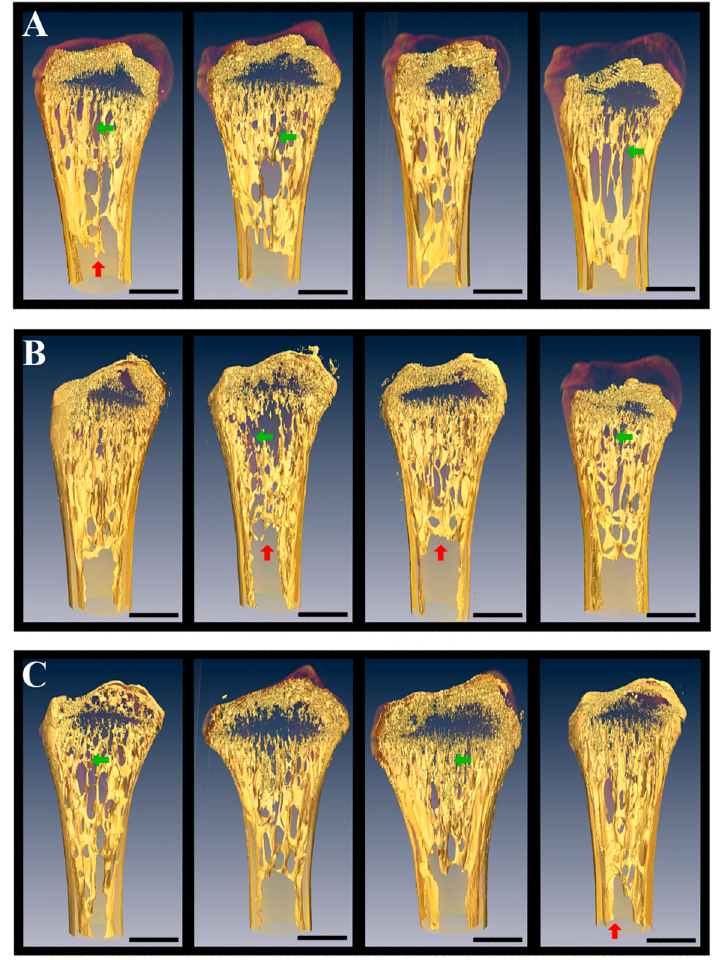
Figure 2. Distal parts of thick-toed gecko femur were examined by SkyScan-1172 microtomograph after the orbital experiment onboard Foton-M3 USC (unmanned spacecraft). Tomographic slices with cancellous bone. ( A ) 12-day flight, ( B ) delayed synchronous control, and ( C ) basal control. The red arrows indicate the di ff erent axial extent of the cancellous bone, the green arrows indicate the di ff erent concentration of trabeculae. Bar: ( A,B,C ) 1 mm.